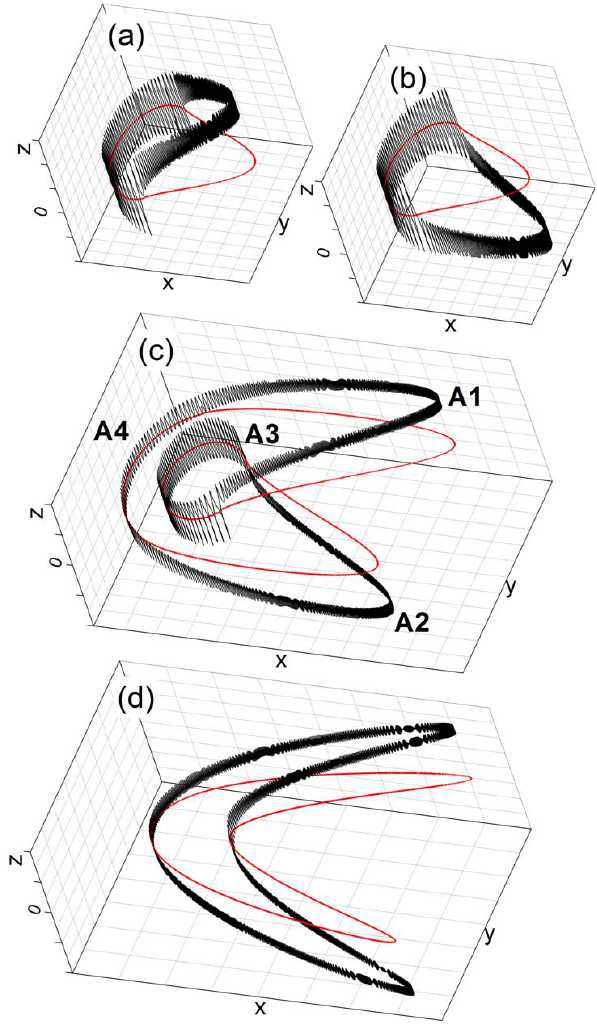
Fig. 1. Characteristic trajectories in current sheets without B y (pan- els a and b , s = 0 and κ = 0 . 01) and with B y (panel c corresponds to s = 0 . 5 and κ = 0 . 01 and panel d corresponds to s = 1 . 0 and κ = 0 . 01). Red curves show projection of trajectories onto plane z =